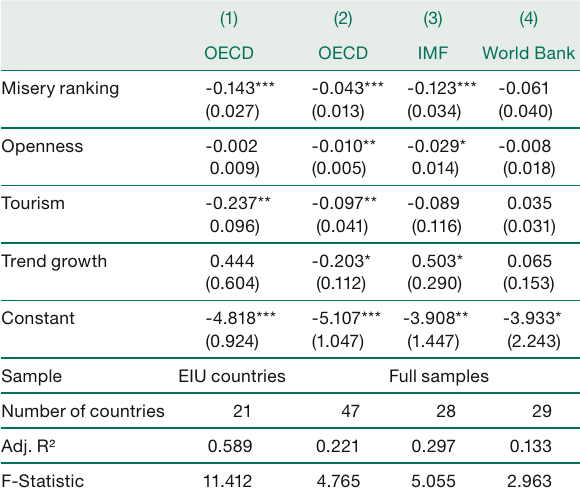
Ranking of GDP growth revisions and the quality of government